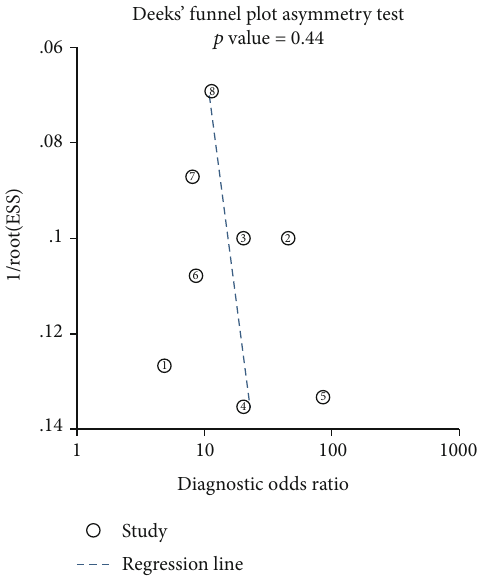
Figure 12: Deeks ’ funnel plot asymmetry test of circRNAs for esophageal